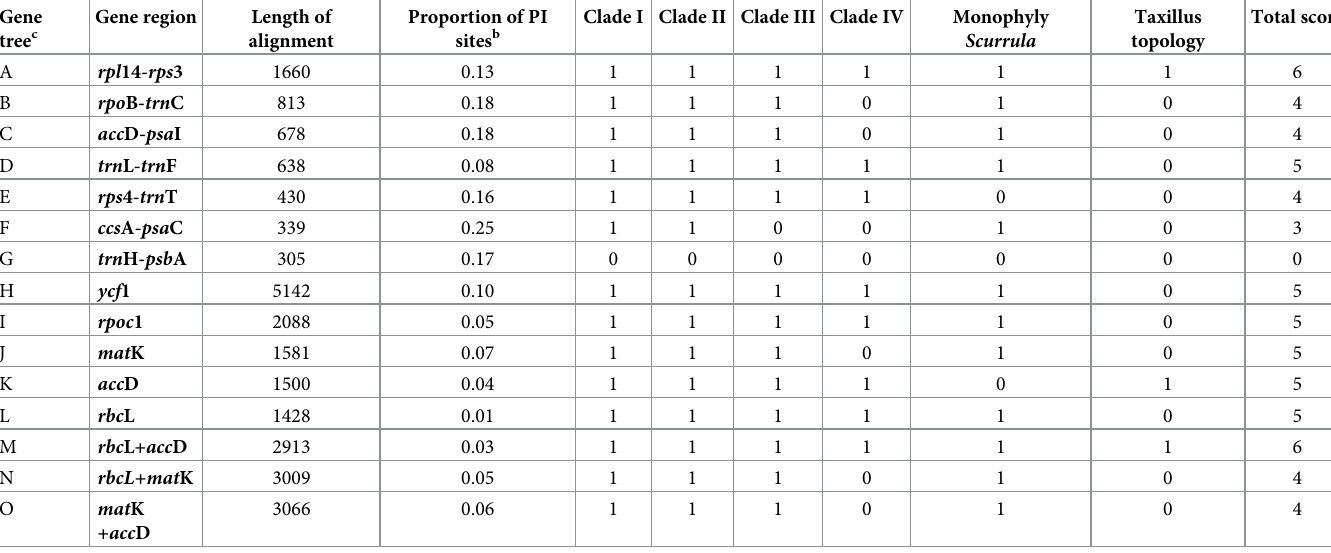
Table 1. Simple phylogenetic utility test scores a for the 29 Taxillus plastid gene